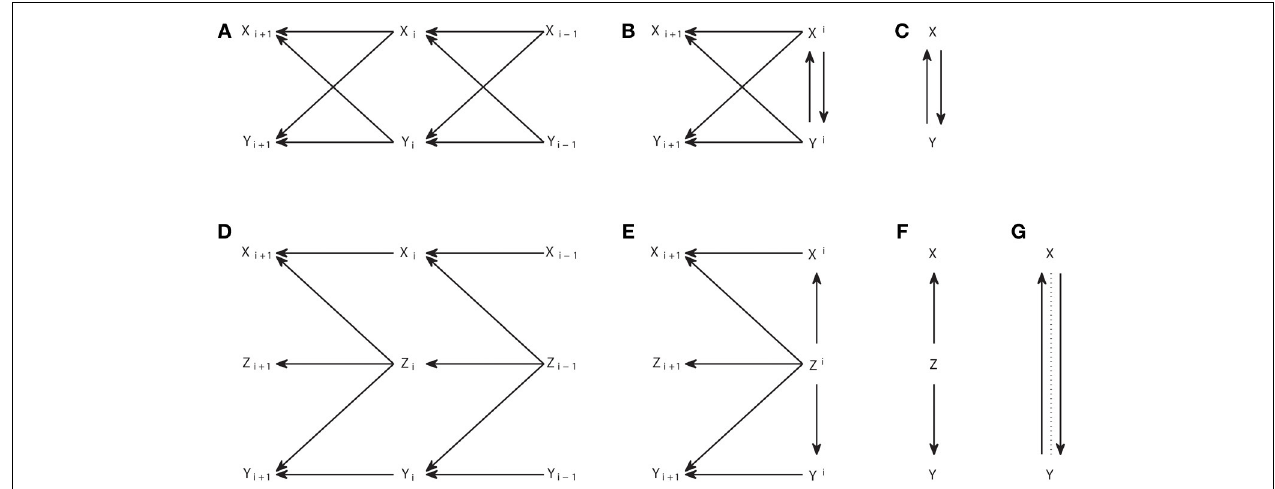
FIGURE 4 | Graphical representations of interacting processes at different scales. (A–C) Represent the same bivariate process at a micro, meso, and macroscopic scale. (D–F) Represent another process also at these